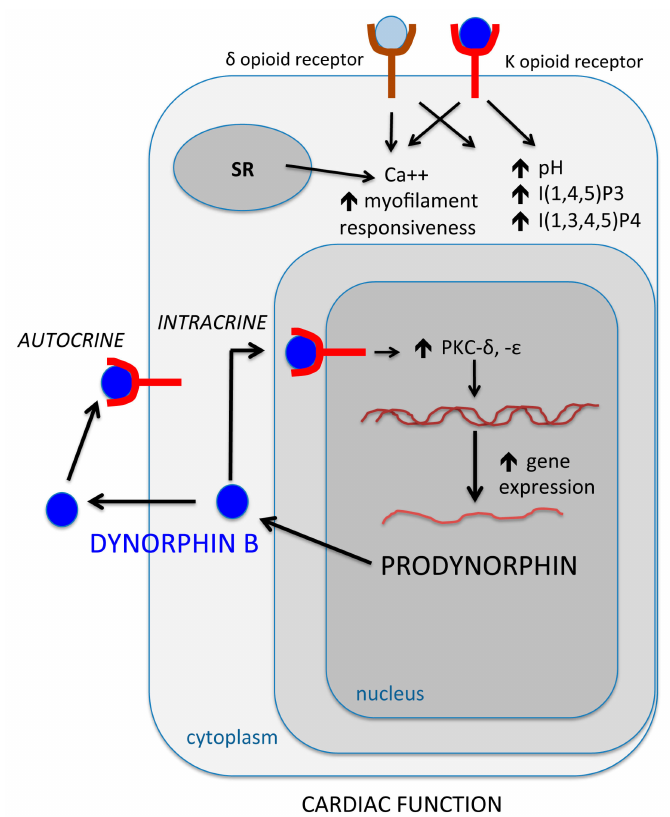
Figure 2. Intracrine dynorphin B pathway in rat ventricular cardiomyocytes. Th figure represents a virtual cell where di ff erent experimental evidence (detailed in the manuscript) is schematically shown. SR: Sarcoplasmic reticulum; Ins(1,3,4,5)P4: Inositol 1,3,4,5-tetrakisphosphate; Ins(1,4,5)P3: Inositol 1,4,5-trisphosphate; PKC: Protein kinase